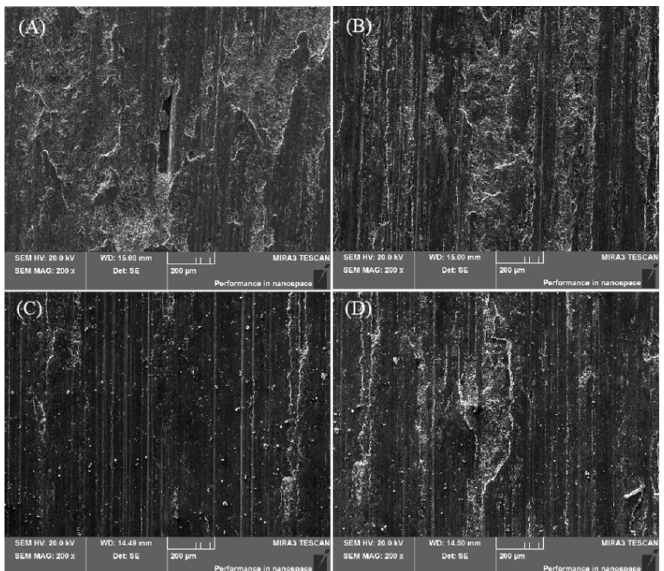
Figure 7. SEM image of SiCp/7085 composites surface after friction-wear test under different ultrasonic treatment time: ( A ) 0 min; ( B ) 5 min; ( C ) 10 min; ( D ) 15 min;.